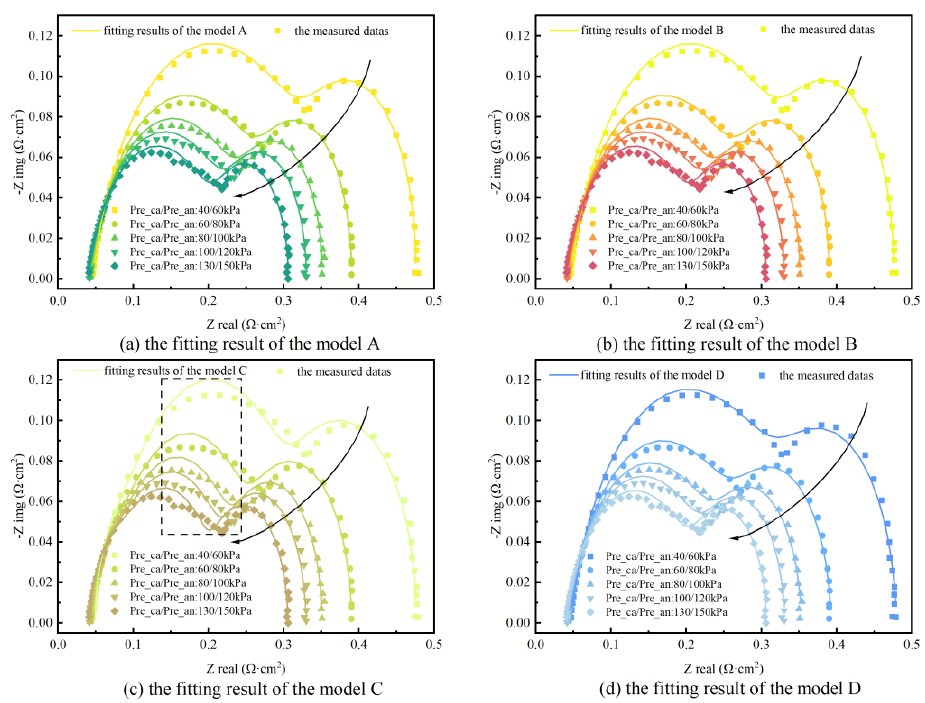
Figure 4. The model-fitting results under different inlet pressure: ( a ) the fitting result of the model A; ( b ) the fitting result of the model B; ( c ) the fitting result of the model C; ( d ) the fitting result of the model D.